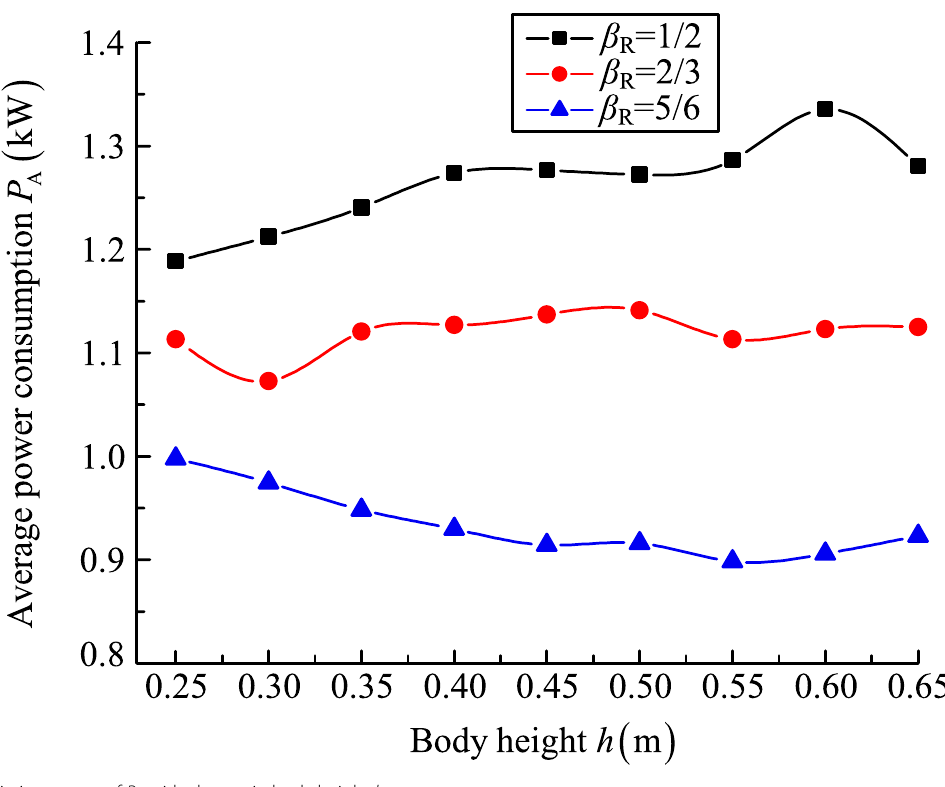
Figure 20 Variation curves of P A with change in body height